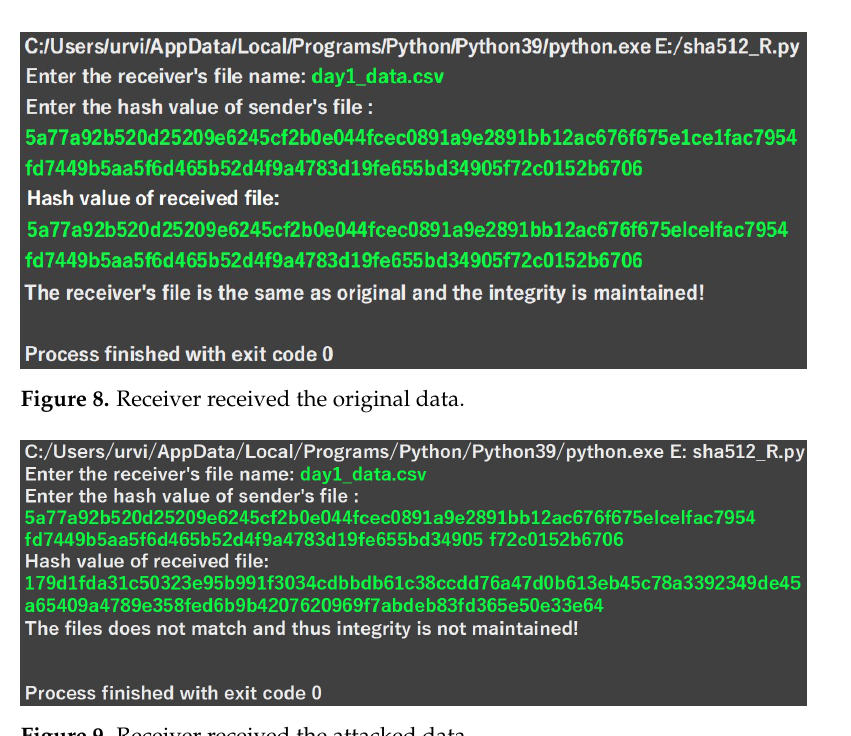
Figure 9. Receiver received the attacked data.